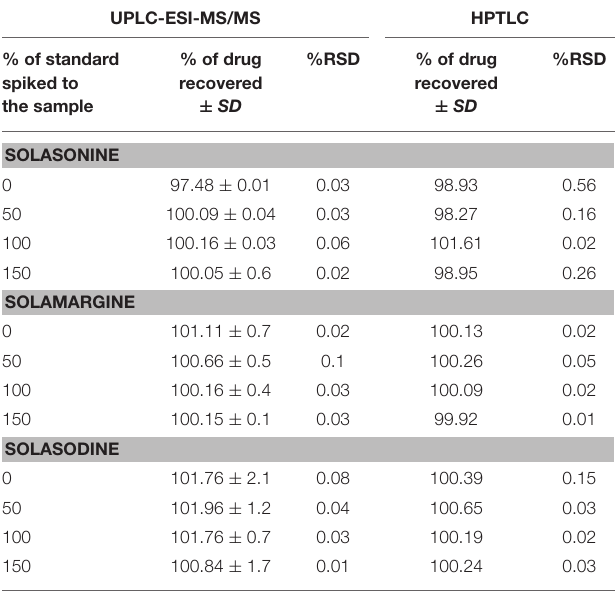
TABLE 5 | Accuracy of UPLC-ESI-MS/MS and HPTLC methods for the estimation of mixed Standards ( n = 3). UPLC-ESI-MS/MS